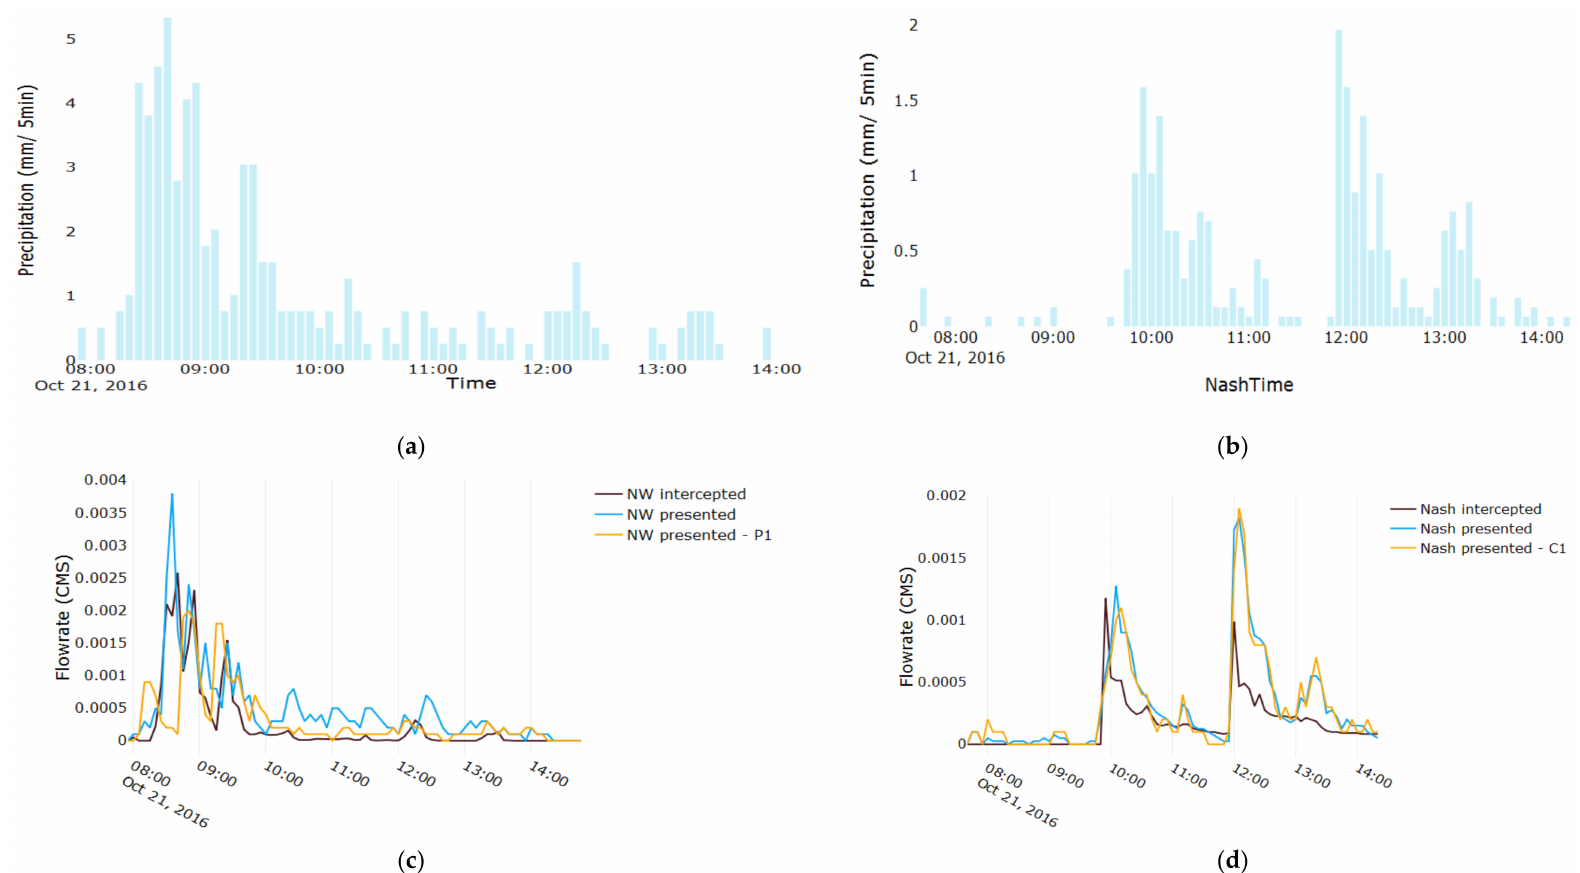
Figure 6. ( a ) On-site precipitation data for Happyland site and ( b ) on-site precipitation data for Nashville site. ( c , d ) presented and intercepted flowrates for NW and Nashville inlets. The runoff flowrates presented to the inlets were calculated using SWMM model. The runoff was calculated using reference precipitation gauges (P1 and C1 marked as orange lines) and on-site rain gauge data (marked as blue line). The black line is observed inflow at